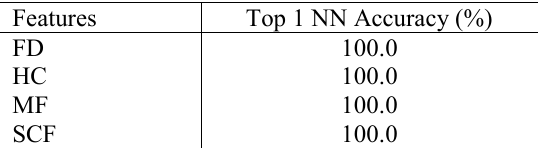
Table 3. Top 1 Nearest Neighbor (NN) accuracy is